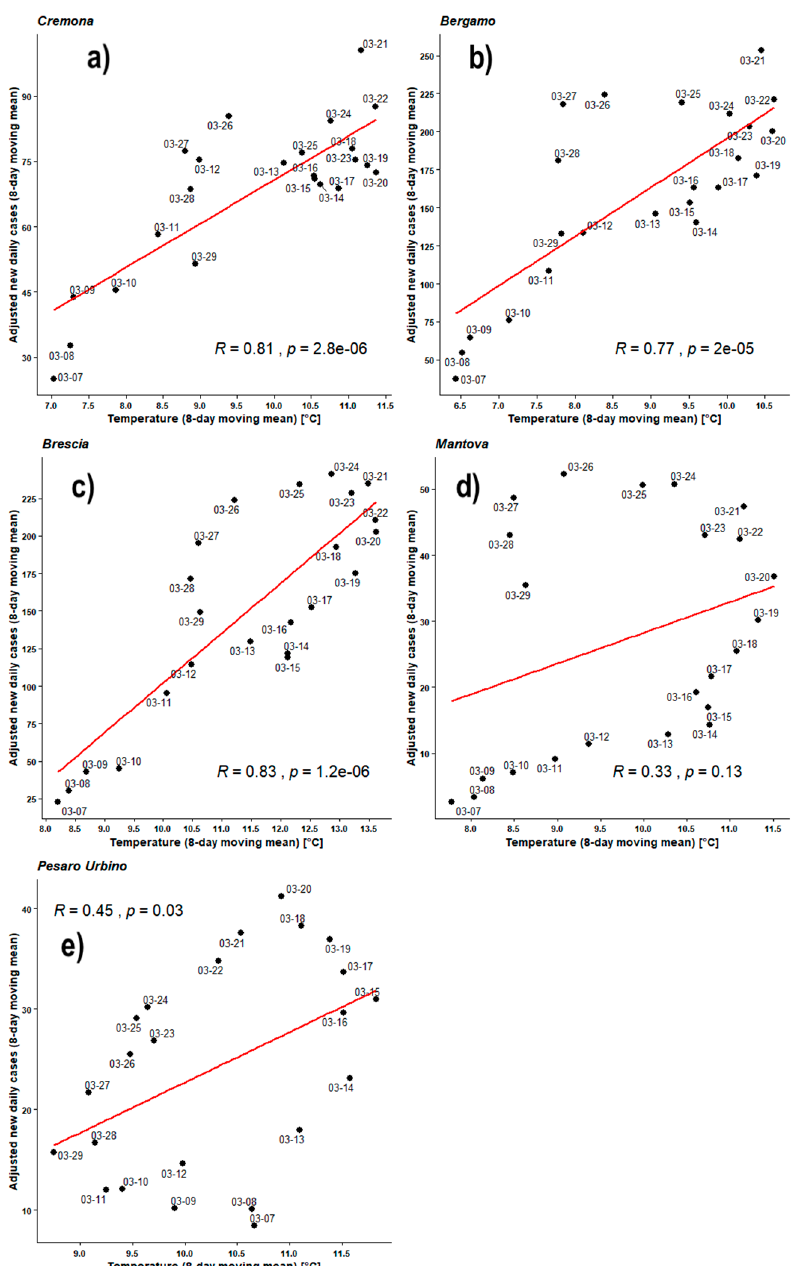
Figure 7. Scatter plot and linear regression for the 8-day moving means of adjusted new daily cases of COVID-19 against outdoor temperatures for five Italian provinces: ( a ) Cremona, ( b ) Bergamo, ( c ) Brescia, ( d ) Mantova, ( e ) Pesaro Urbino. Labels report, in MM-DD format, the last day of the moving means. Pearson correlation coe ffi cient is reported as ‘R’ while probability value is reported as ‘ p